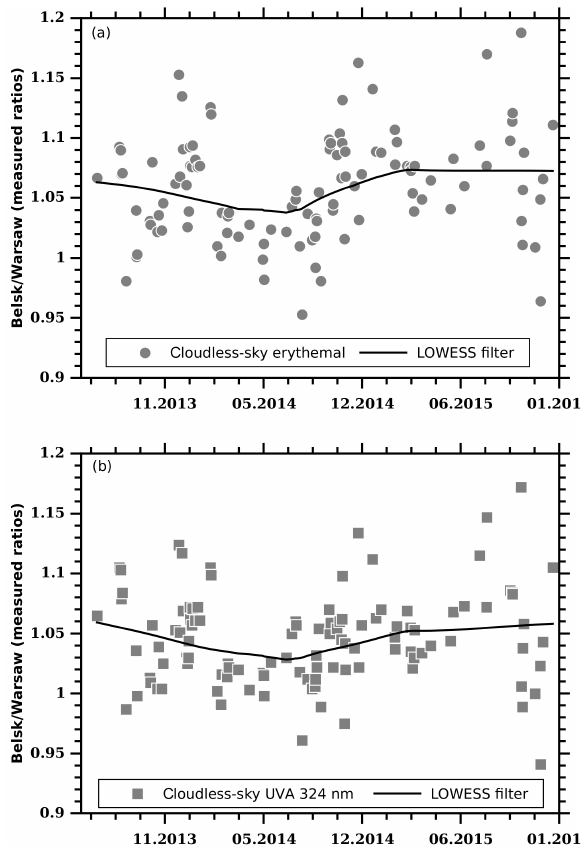
Figure 3. The Belsk / Warsaw ratio between the partial daily 3h doses (noon − 3.5h, noon − 0.5h) measured during cloudless-sky conditions existing over both sites for erythemal doses (a) and UVA (324nm) doses (b) . Solid curves represent the data smoothed by the LOWESS filter.